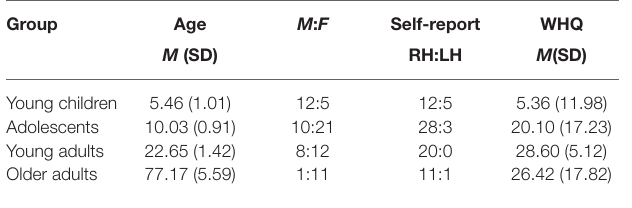
TABLE 1 | Participant demographics according to group: Age (Mean: Standard Deviation), Male: Female, Self-report Right handers: Left handers, Total Waterloo Handedness Questionnaire Score.